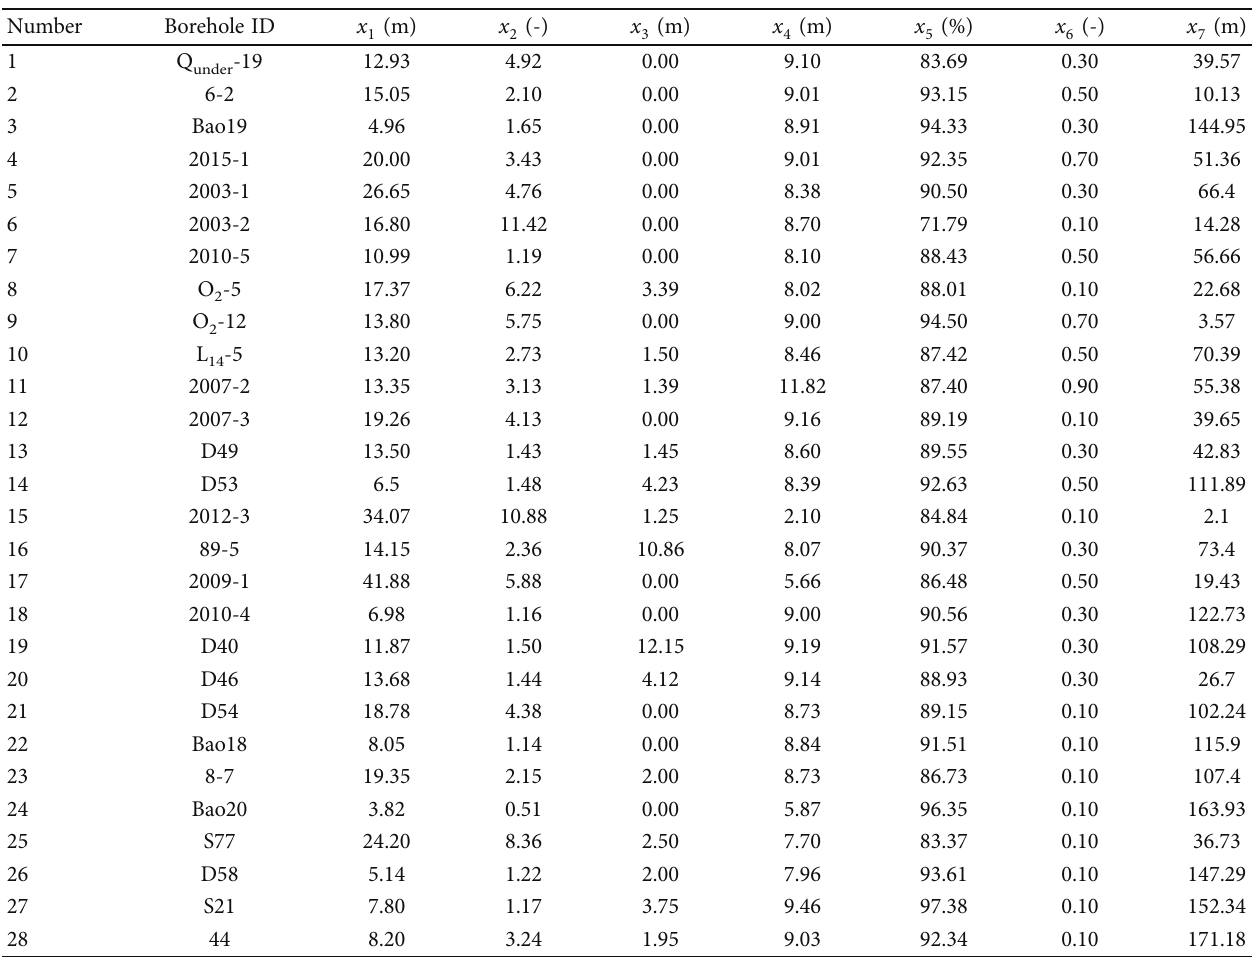
Table 2: Index data of boreholes.